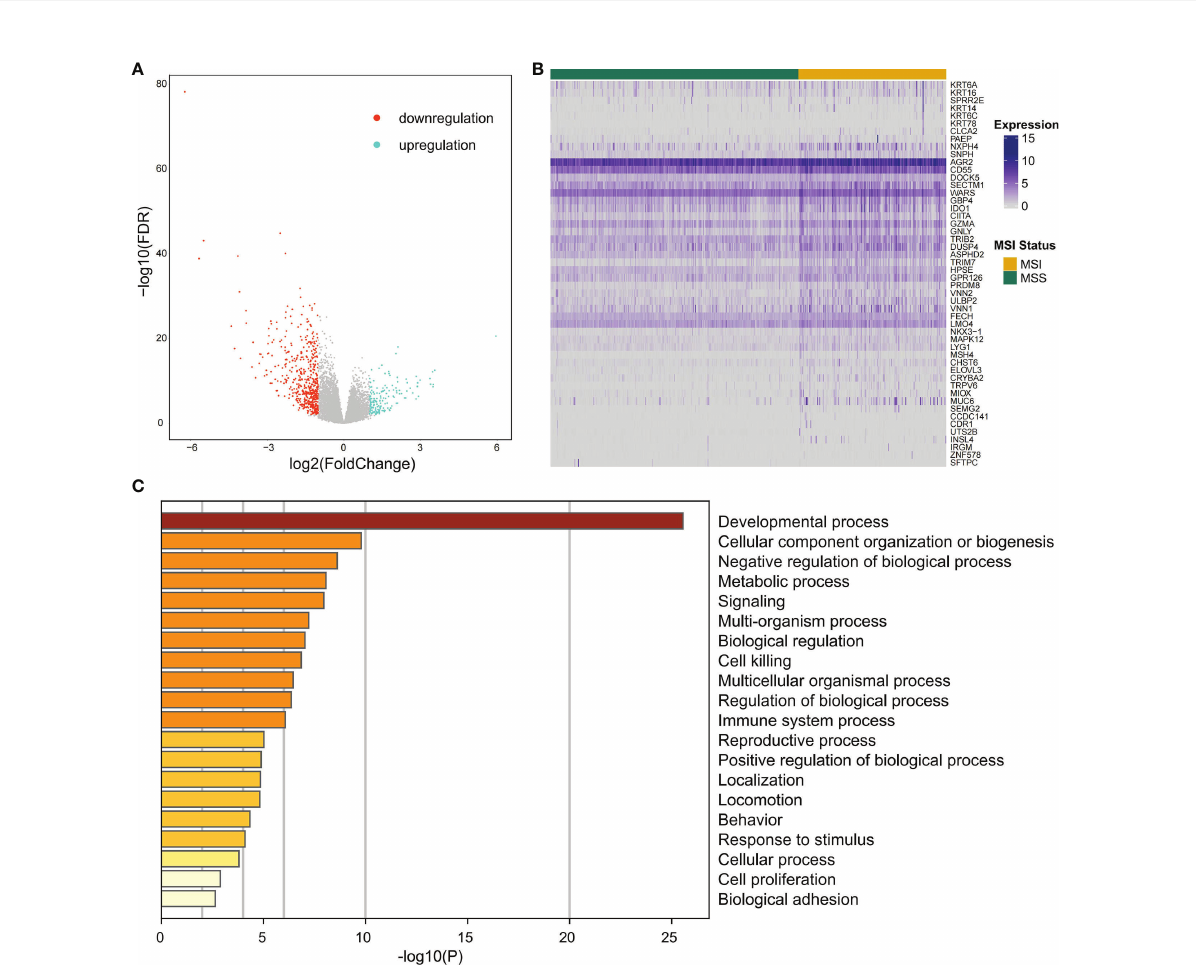
FIGURE 3 The differentially expressed gene identi fi cation and functional analysis. (A) Volcano plot for differential expression genes (DEGs) between MSI and MSS samples from TCGA COAD cohort. Blue points mean upregulation, and orange points mean downregulation. (B) The heatmap shows the expression of the top 50 DEGs in samples from TCGA COAD cohort. (C) For 701 signi fi cant DEGs, pathway and process enrichment analysis has been done with GO Biological Processes. The graphical graph revealed the top 20 enrichments having P < 0.01. A P-value was multi-test adjusted in log